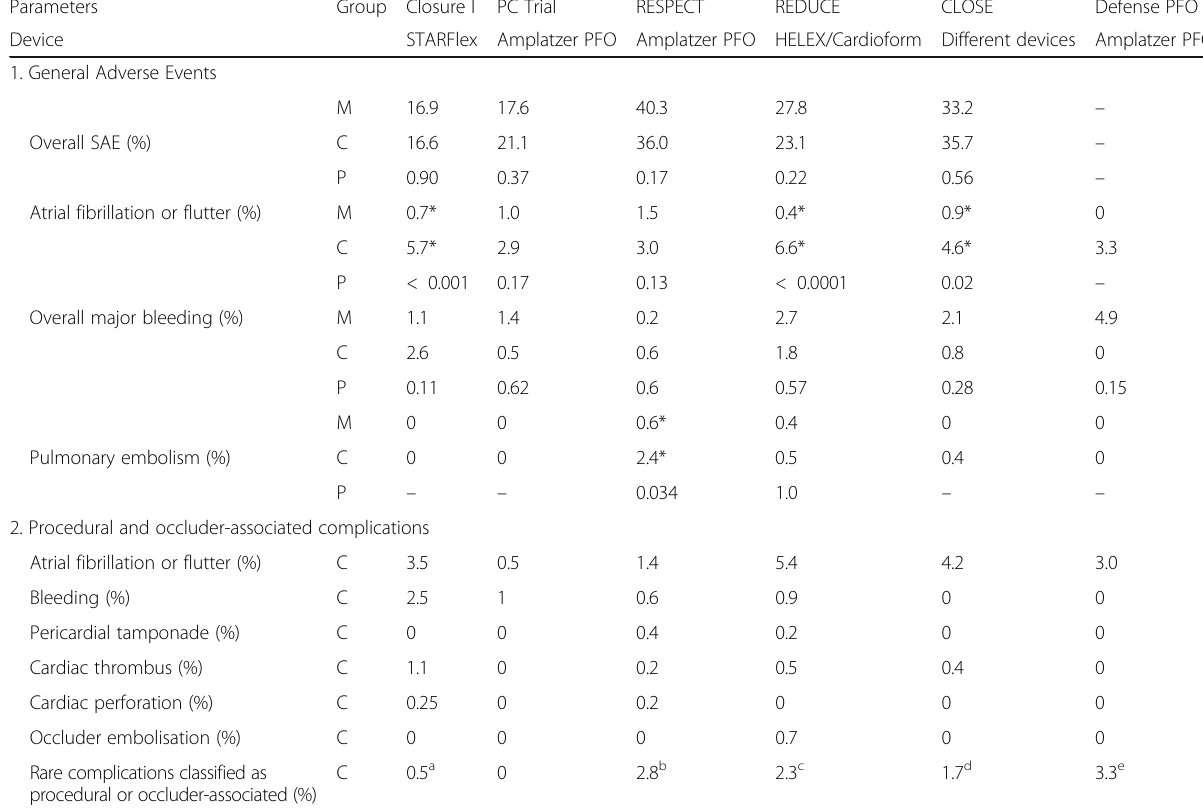
Table 4 Adverse events in the six randomised studies of PFO closure in cryptogenic stroke Parameters Group Closure I PC Trial RESPECT REDUCE CLOSE Defense PFO Device